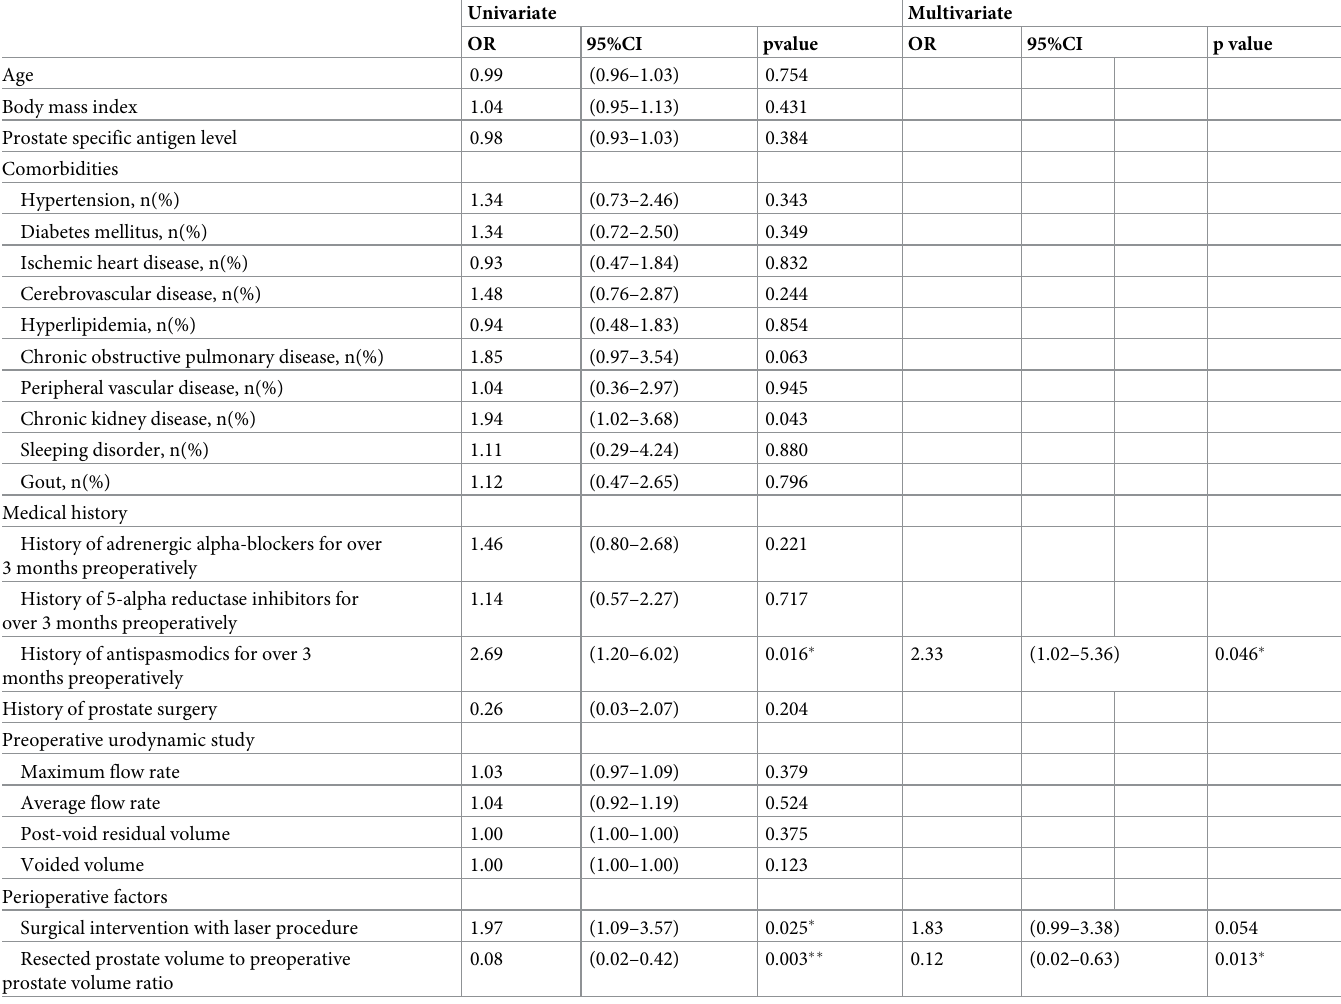
Table 3. Logistic regression analyzing factors that are associated with postoperative